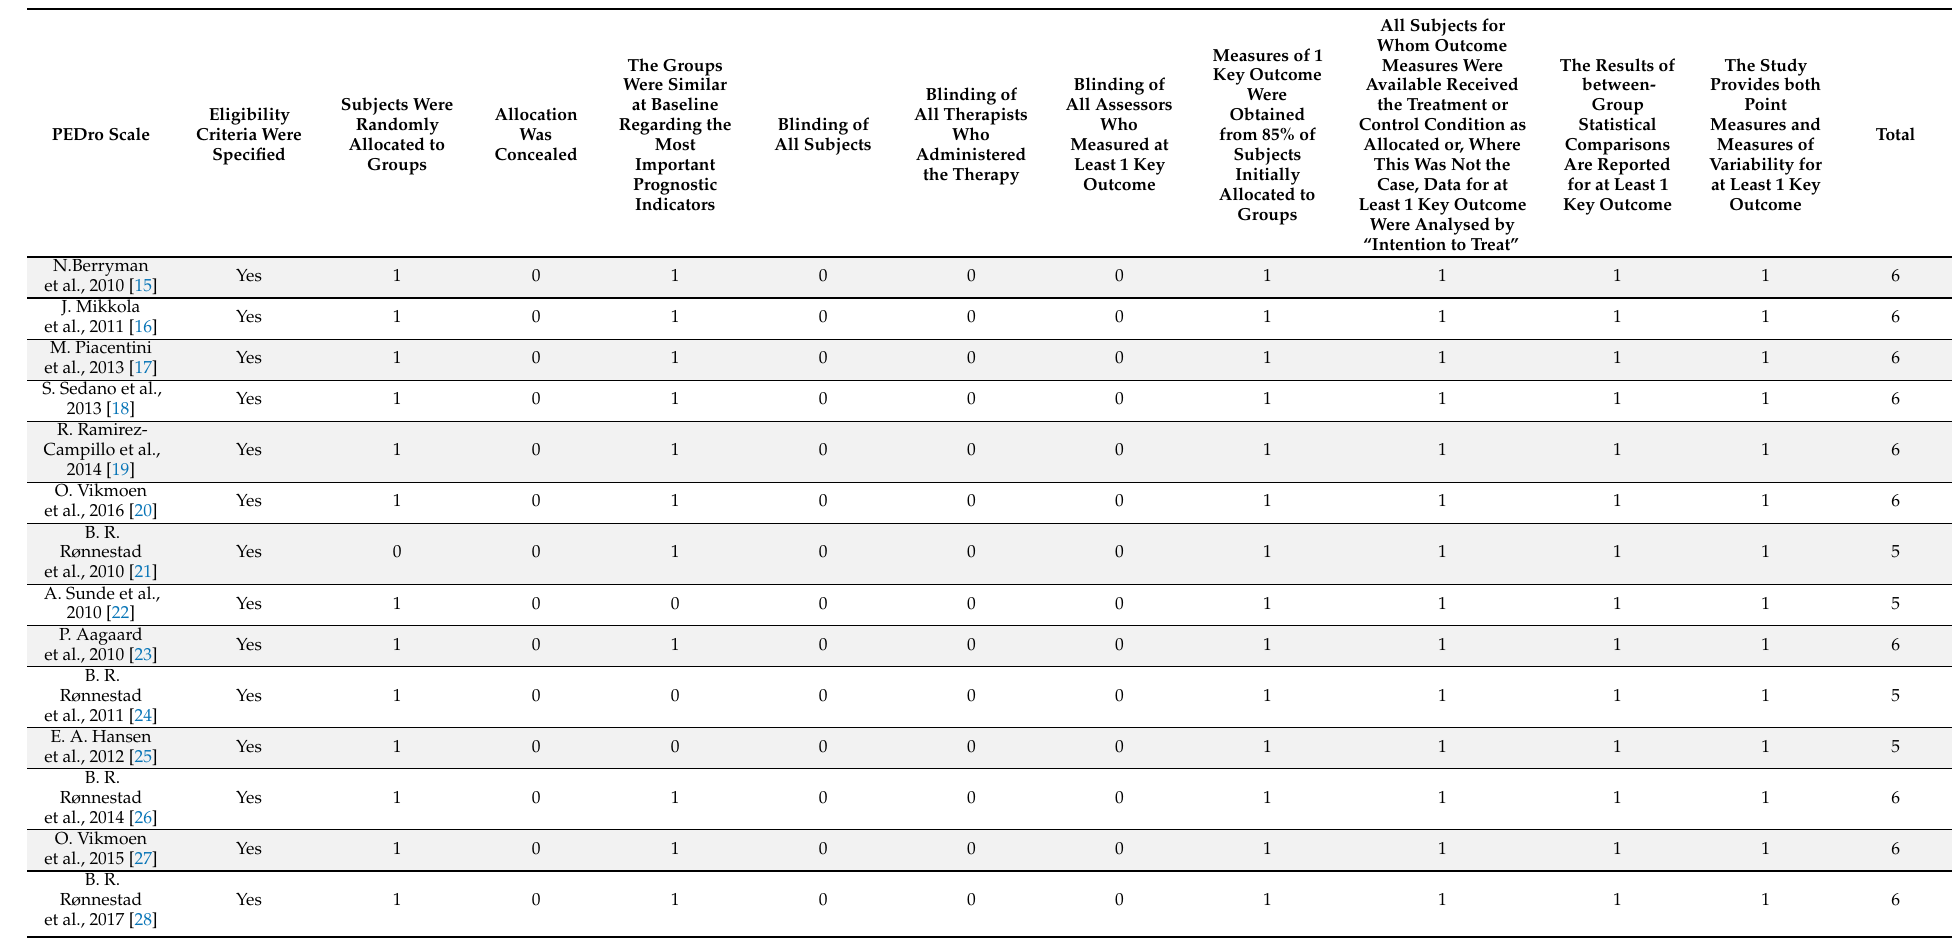
Table 1. Studies value by items in the PEDro